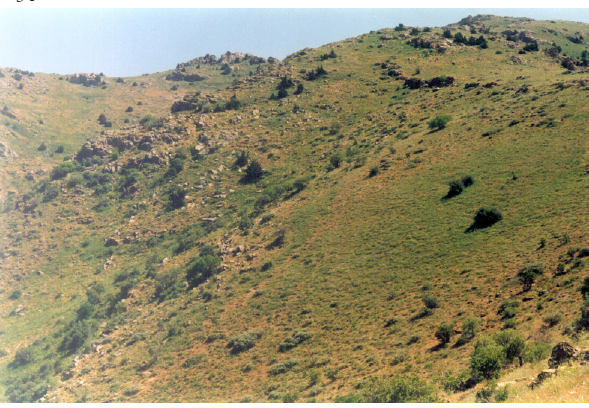
Fig. 11. Amygdalus elaeagnifolia-Acer community